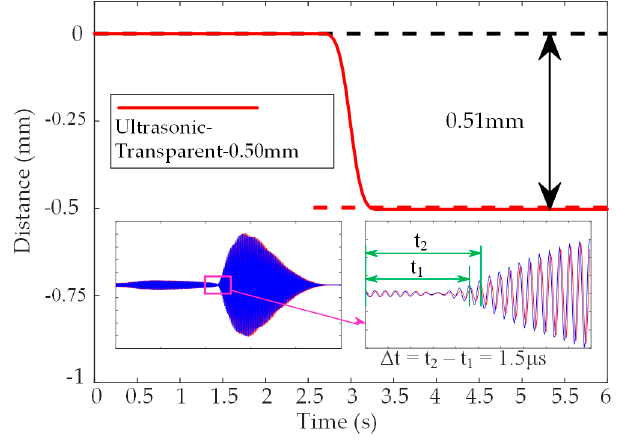
Figure 11. Detection results of the PMUTs-based ultrasonic sensor when using transparent acrylic plate with thicknesses of 0.501 mm and the changes of the detection signals.